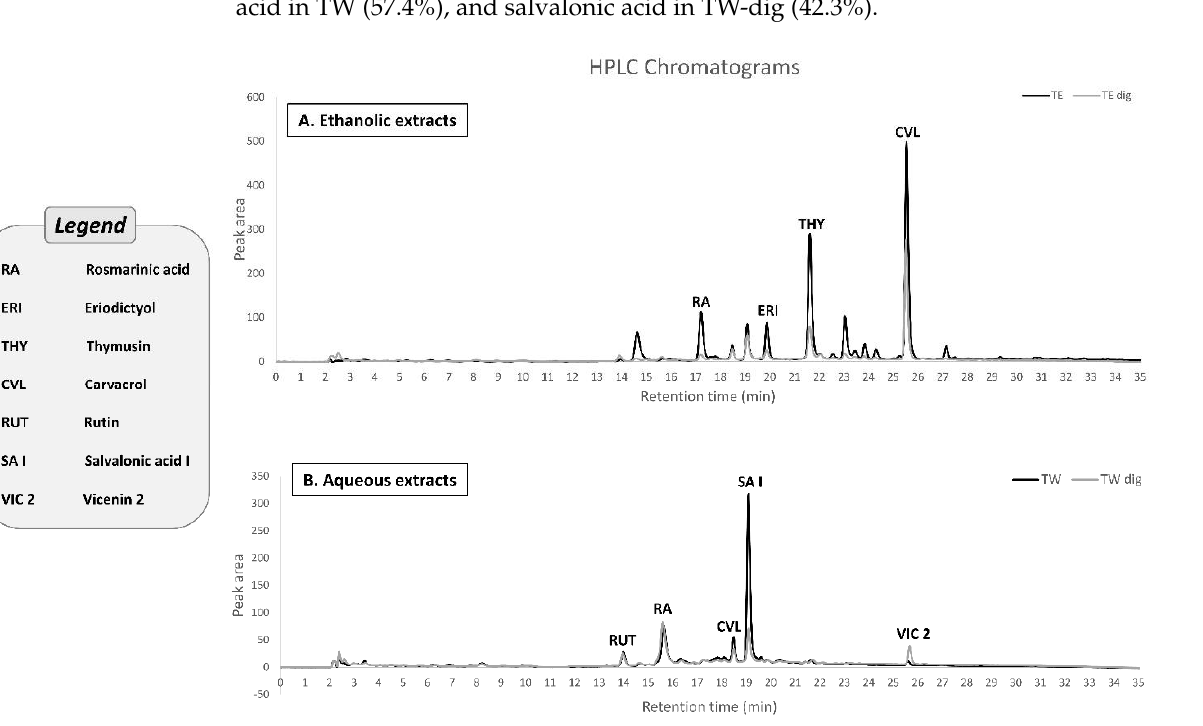
Figure 3. HPLC–UV chromatographic profiles for both ethanolic and aqueous extracts of Thymbra spicata before and after digestion wherein their pure polyphenols were recorded at 280 nm: ( A ) Chromatogram of the ethanolic extract (TE and TE-dig) showing the following peaks: 1: carvacrol;